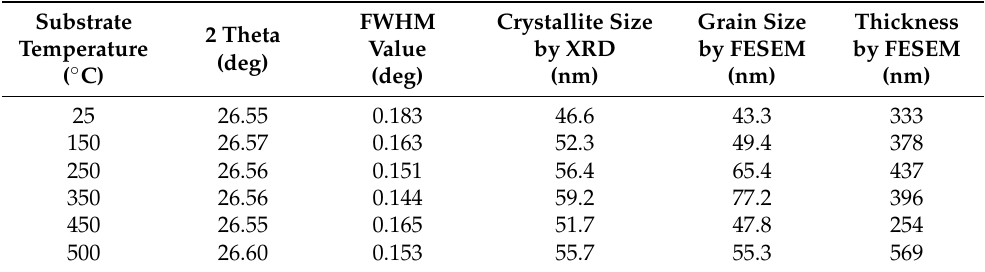
Table 1. Detailed values representing the structural properties of CdS thin films fabricated at various substrate